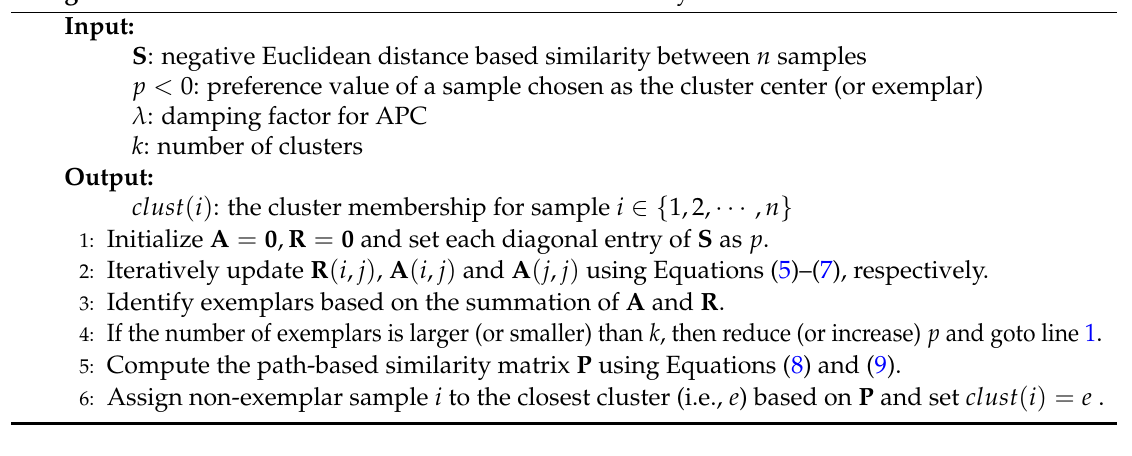
Algorithm 1: APC-PS: APC Based on Path-Based